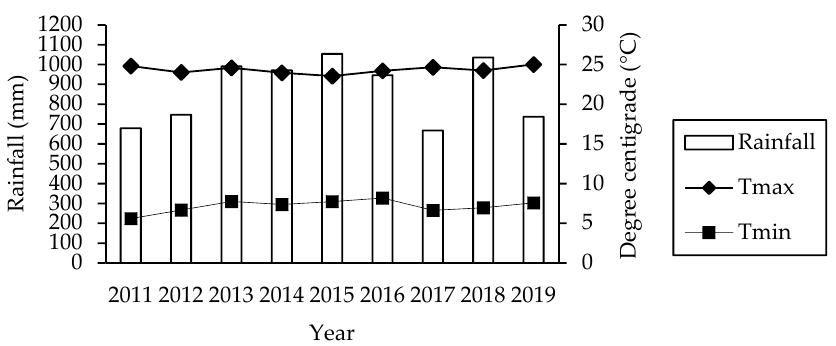
Figure 1. Rainfall and mean temperatures during the years 2011–2019 in the present study.